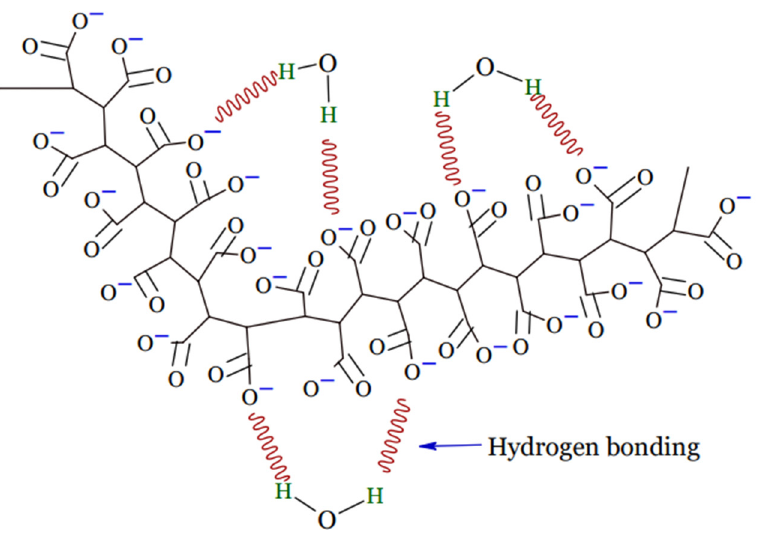
Figure 1. Structure of hydrogel.